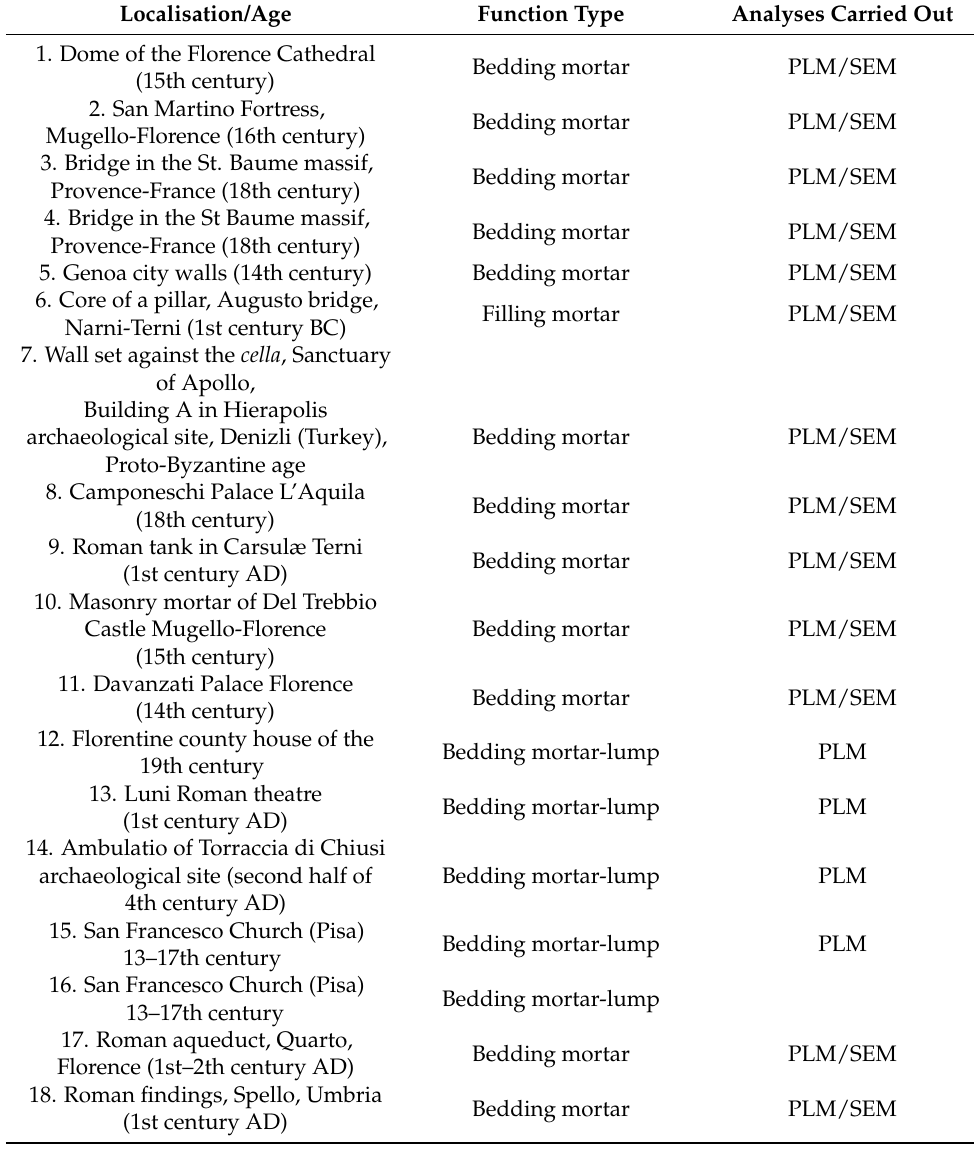
Table 1. Description of the mortars and performed